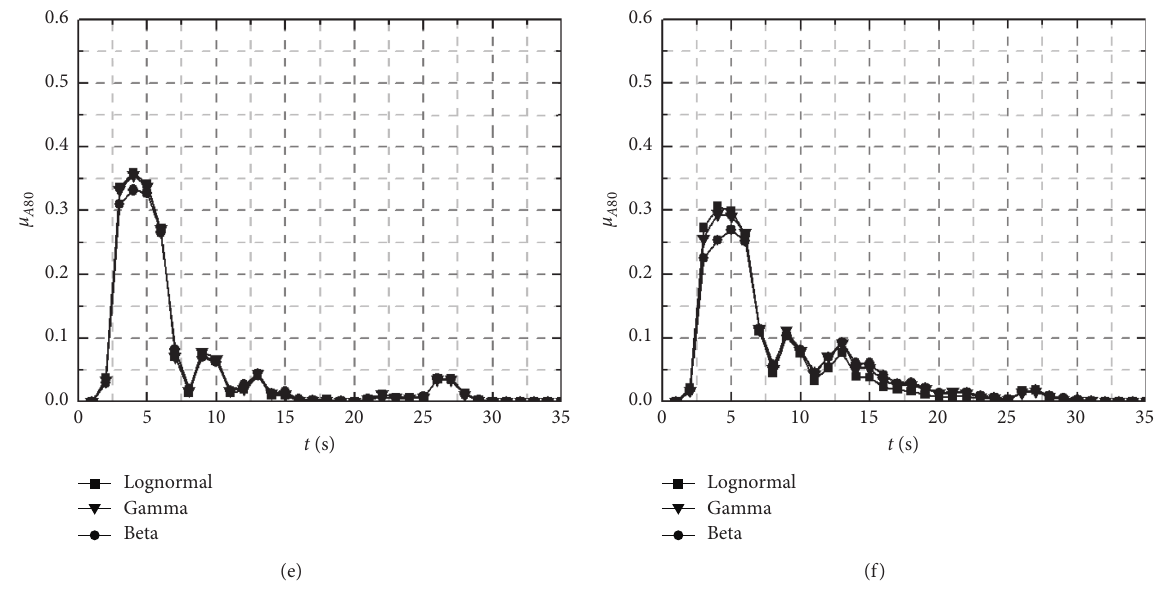
Figure 2: Time history curve of mean liquefaction range with different distributions: (a) δ CoV G � 0.3; (c) δ x � 6m and CoV G � 0.5; (d) δ x � 60m and CoV G � 0.1; (e) δ x � 60m and CoV G � 0.3; (f) δ x � 60m and CoV G �